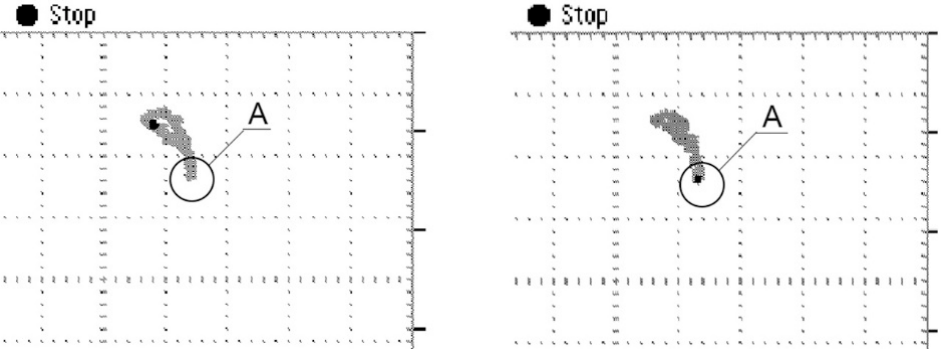
Figure 16. The figures from a pair of sensors with shift by π : left—for deflection { Δ v 1 = (+)0.04; Δ v 2 = (+)0.02; Δ v 3 = 0.00}, right—for deflection { Δ v 1 = (+)0.01; Δ v 2 = ( − )0.015; Δ v 3 = ( − )0.005}. The zero value CH1 = CH1 = (–)9 DIV= (–)4.5 V; CH1 = CH2 = 0.5 V/DIV; A—fragments caused by local inhomoge- neity of the material.